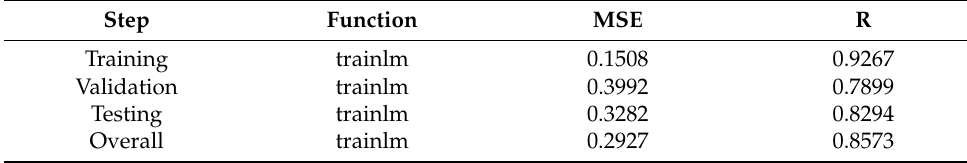
Table 4. Summary of different model evaluation parameters of LM